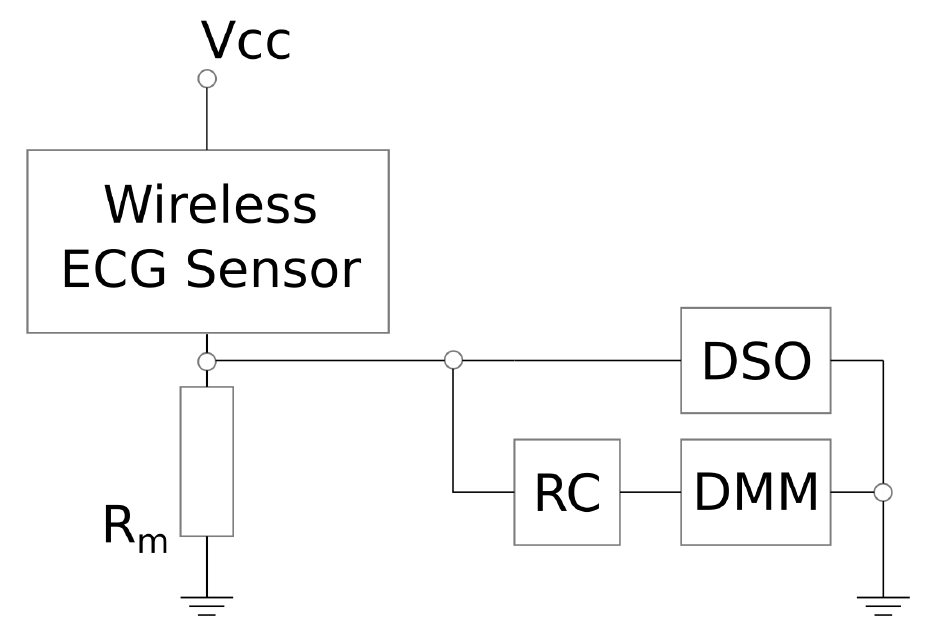
Figure 2. Schematic presentation of the current consumption measurement